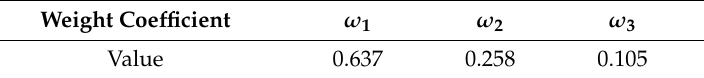
Table 8. Weight coefficients.